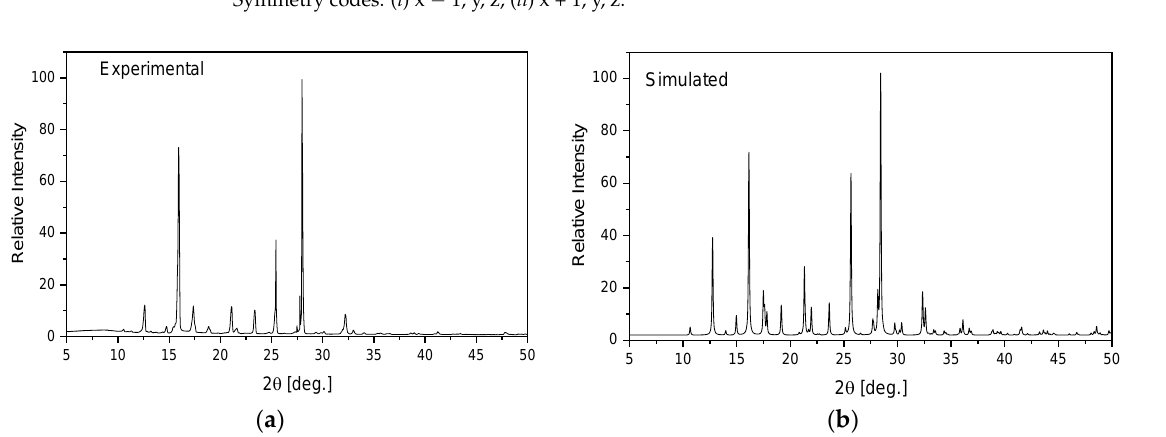
Figure 1. Experimental ( a ) and simulated ( b ) from an X-ray structural analysis on a single crystal for TPa-NH 2 . Table 1. X-ray and DFT optimized geometrical parameters (Å ,°) of TPa-NH 2 .